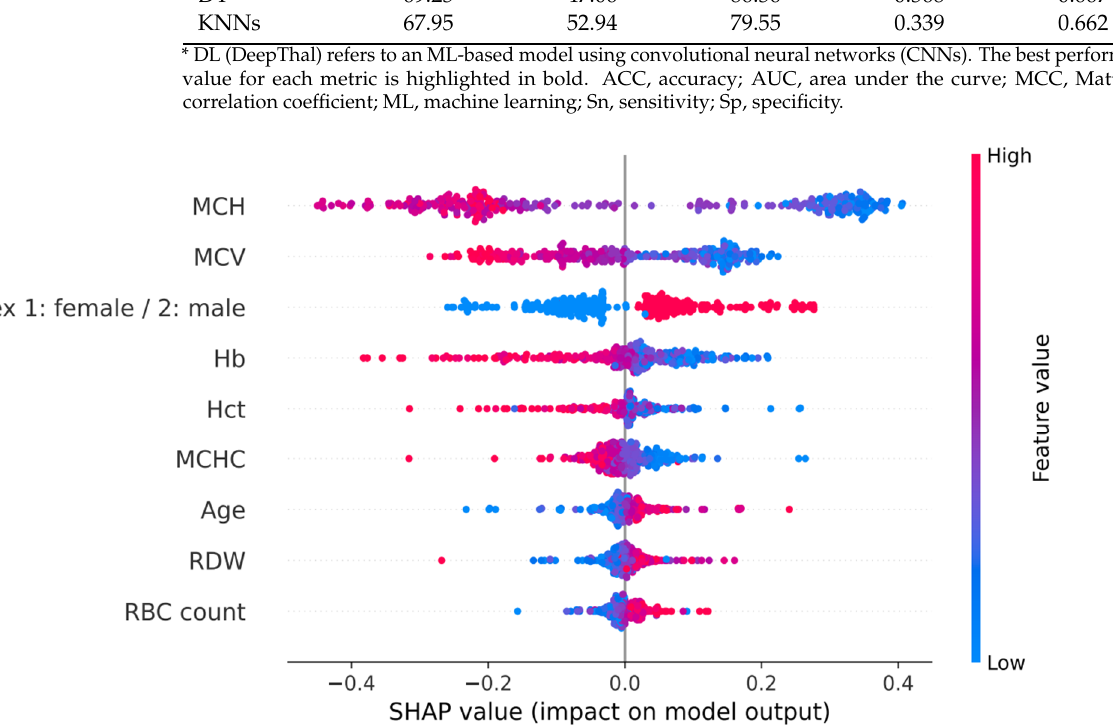
Figure 3. SHAP values of the nine red blood cell indices employed by the proposed DeepThal, where positive and negative SHAP values represent the α + -thal trait and control predictions, respectively. Hb, hemoglobin; Hct, hematocrit; MCH, mean corpuscular hemoglobin; MCHC, mean corpuscular hemoglobin concentration; MCV, mean corpuscular volume; RBC, red blood cell; RDW, red blood cell distribution width. Table 4. Cross-validation results of different ML-based predictors in the training dataset.